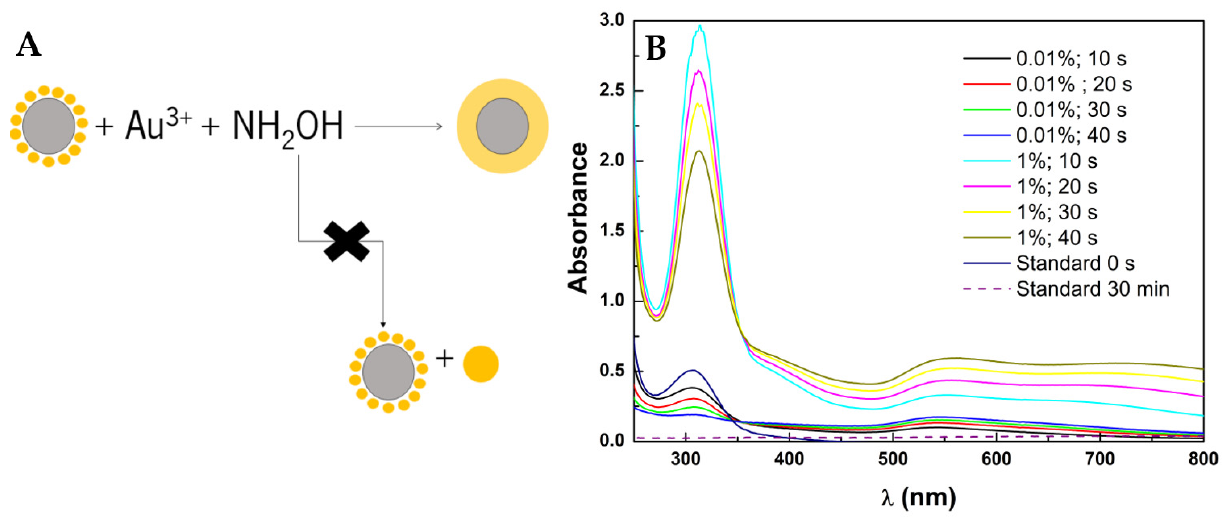
Figure 5. ( A ) Representation of the seeding method using hydroxylamine for the growth of a gold shell. ( B ) Absorption spectra of manganese ferrite/gold core/shell nanoparticles with increasing time, after the addition of hydroxylamine and chloroauric acid (0.01% and 1%).